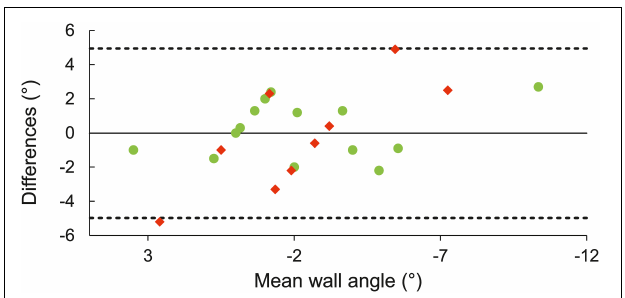
FIGURE 4 | Limits of agreement plot of estimated CA from MOB and CA from mathematical model. The solid horizontal line represents differences between the two estimates of CA, the dashed lines upper and lower 95% limits of agreement. Green and red circles designate participants with MOB determined as a sudden increase and onset of a plateau in (cid:49) deoxy[heme],